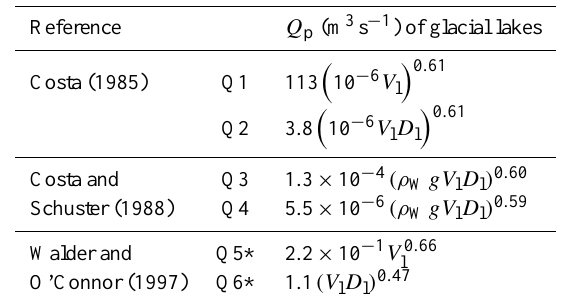
Table 9. Empirical regression equations relating peak discharge Q p of glacial lakes to outburst volume V l and lake depth (dam height) (worst